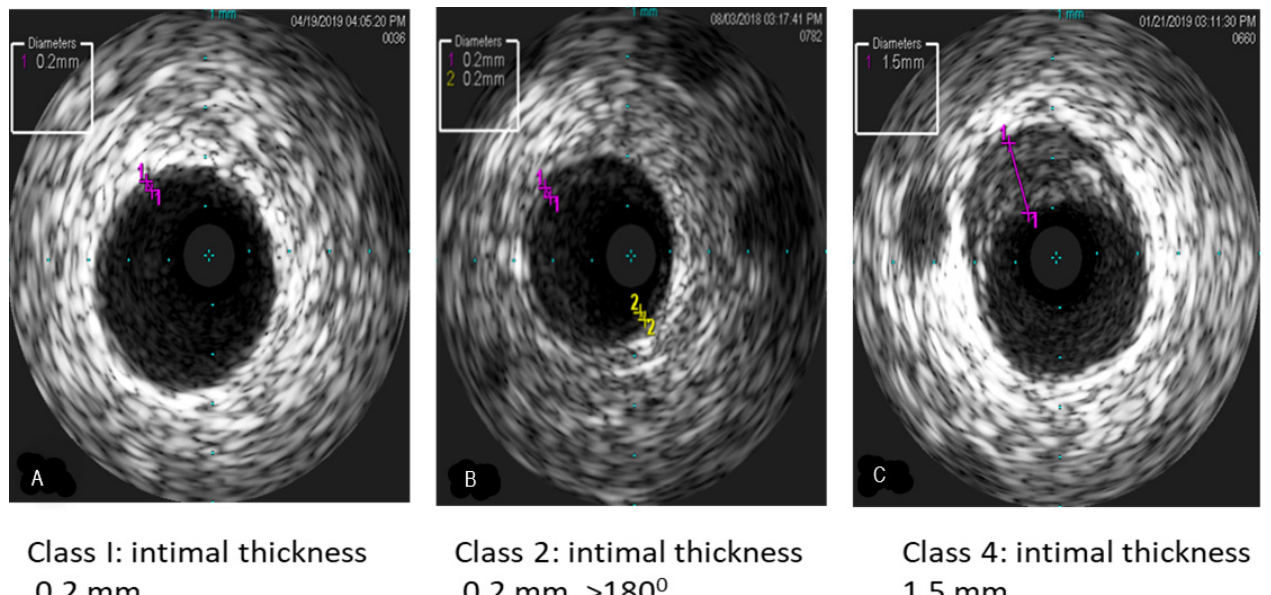
Figure 7. The illustration of IVUS shows the progression of CAV. ( A ) Class 1 (minimal) < 0.3 mm intimal thickening, ( B ) Class 2 (mild) < 0.3 mm intimal thickness and >180 degrees; and ( C ) Class